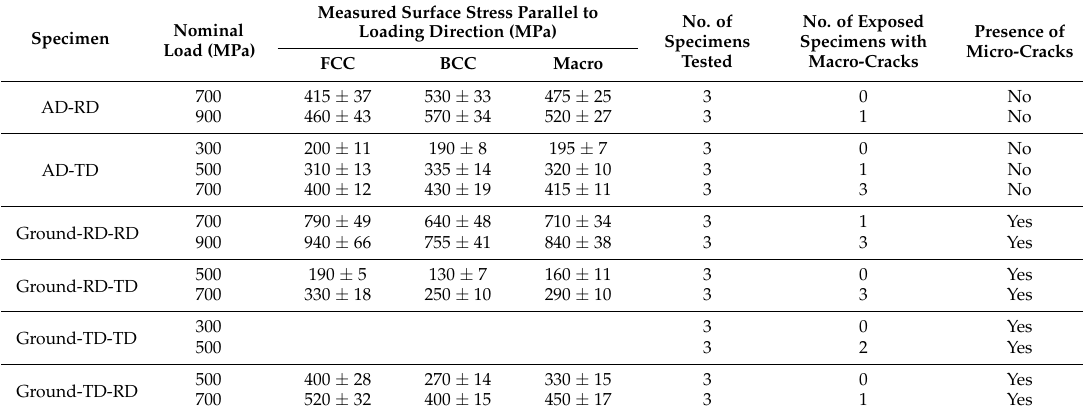
Table 4. Micro- and macroscopic cracking after exposure 22 h under different four-point bend loading values; the measured surface stresses from Figure 5 are included for comparison.